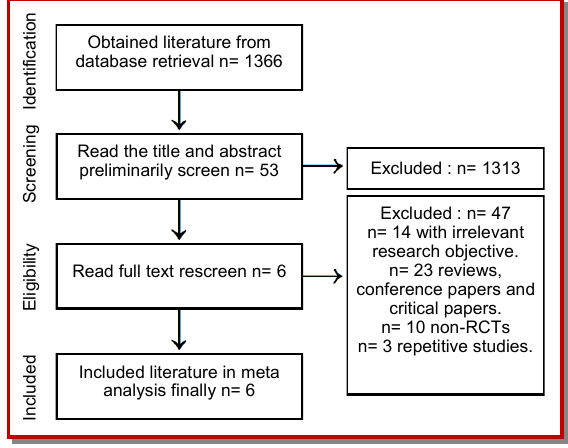
Figure 1: Flow-chart of selection process and